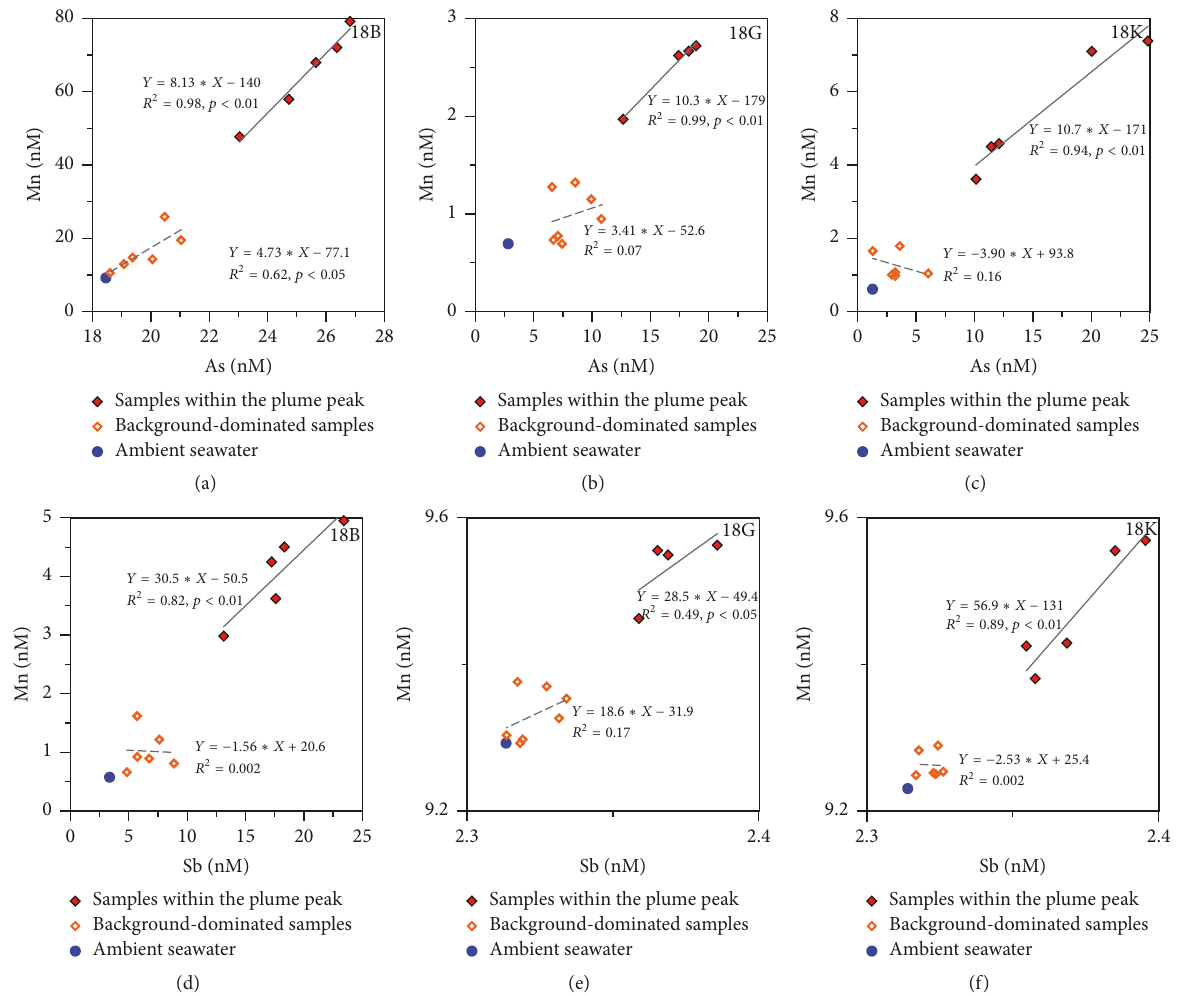
Figure 4: Correlations between Mn and As at (a) Station 18B, (b) Station 18G, and (c) Station 18K; correlations between Mn and Sb at (d) Station 18B, (e) Station 18G, and (f) Station 18K in the plume in the eastern Manus